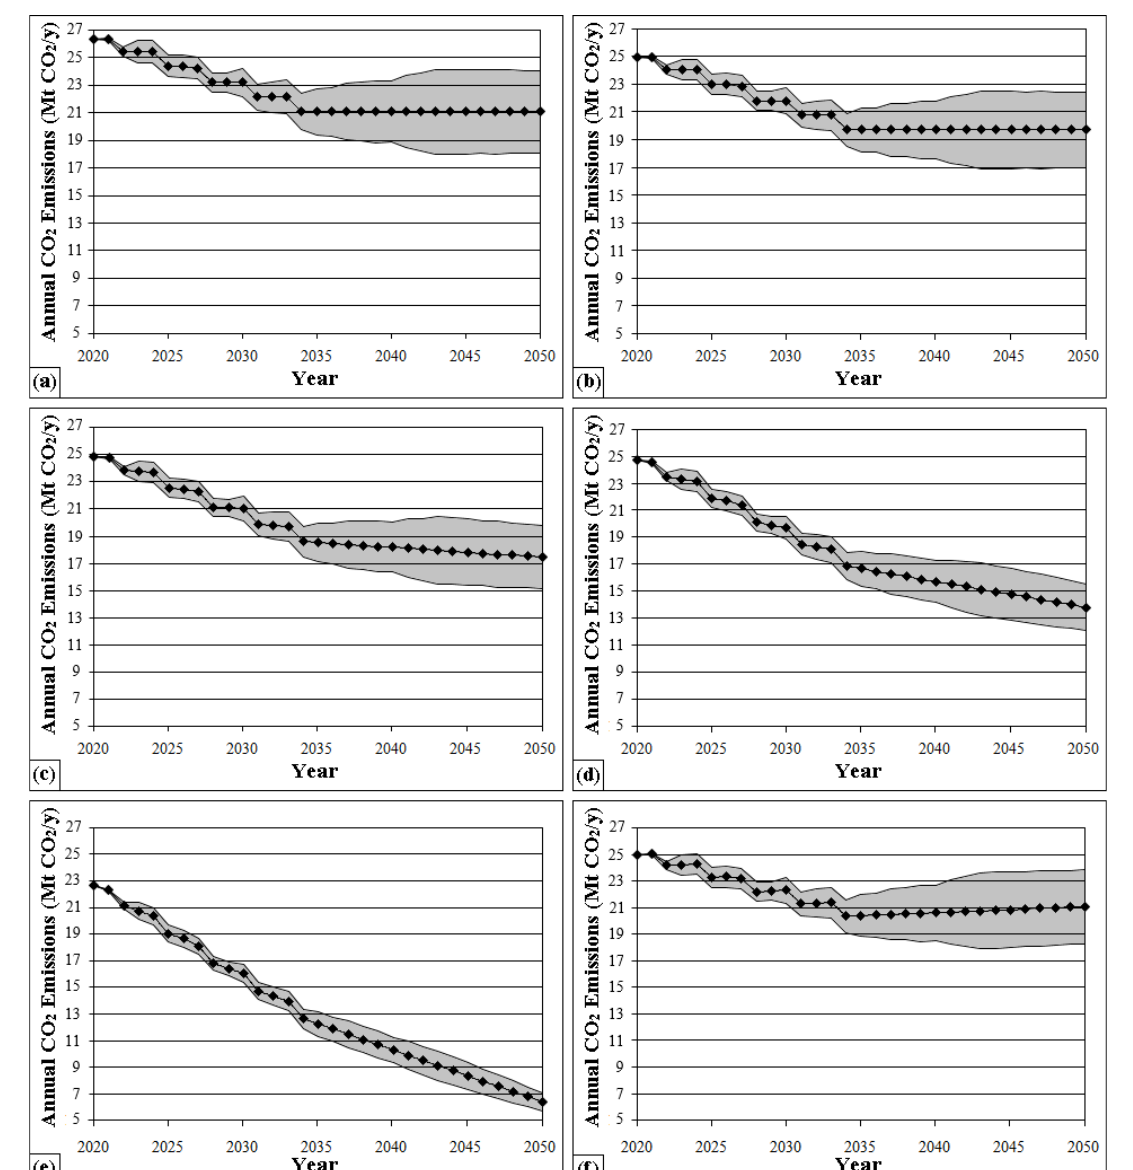
Figure A2. Projections of annual CO 2 emissions from the Serbian electricity generation sector by the end of 2050, taking into account the EU’s “20-20-20” targets, that is, Scenario 2, namely: ( a ) Sub-scenario 2-1; ( b ) Sub-scenario 2-2; ( c ) Sub-scenario 2-3; ( d ) Sub-scenario 2-4; ( e ) Sub-scenario 2-5; and ( f ) Sub-scenario 2-6.